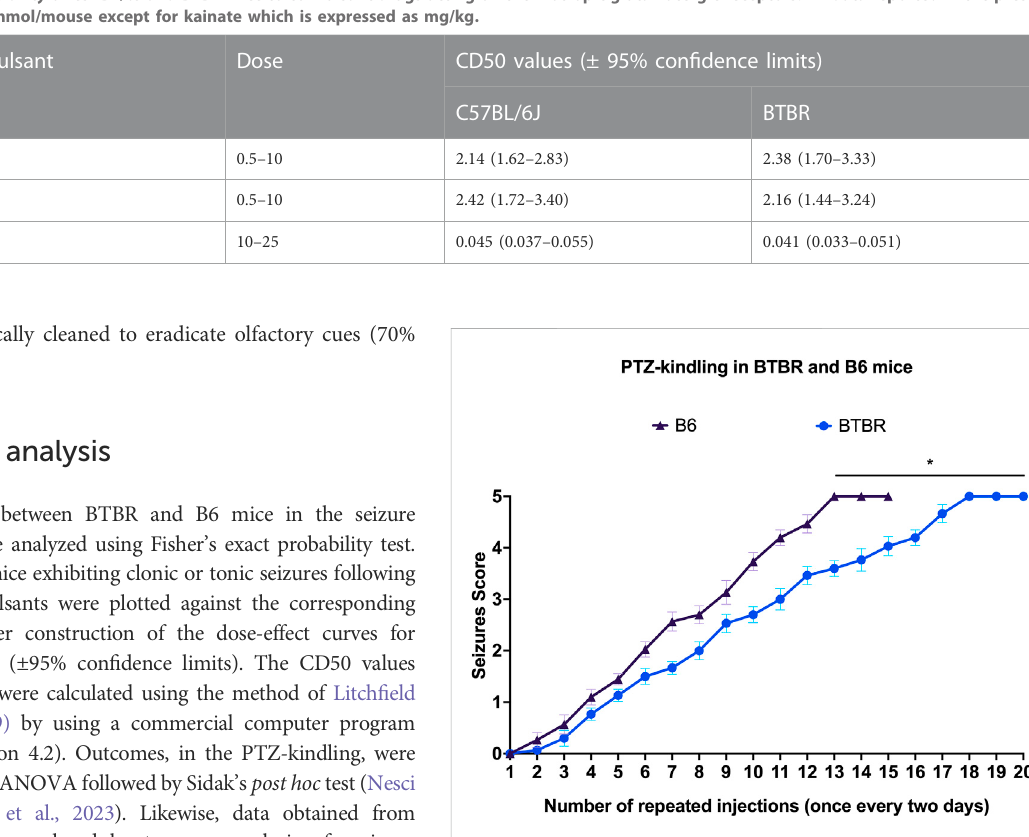
FIGURE 1 PTZ kindling development. Progression of kindling in B6 and BTBR mice. *Indicates p < 0.01 vs. B6 mice. B6 = C57BL/6J; PTZ =